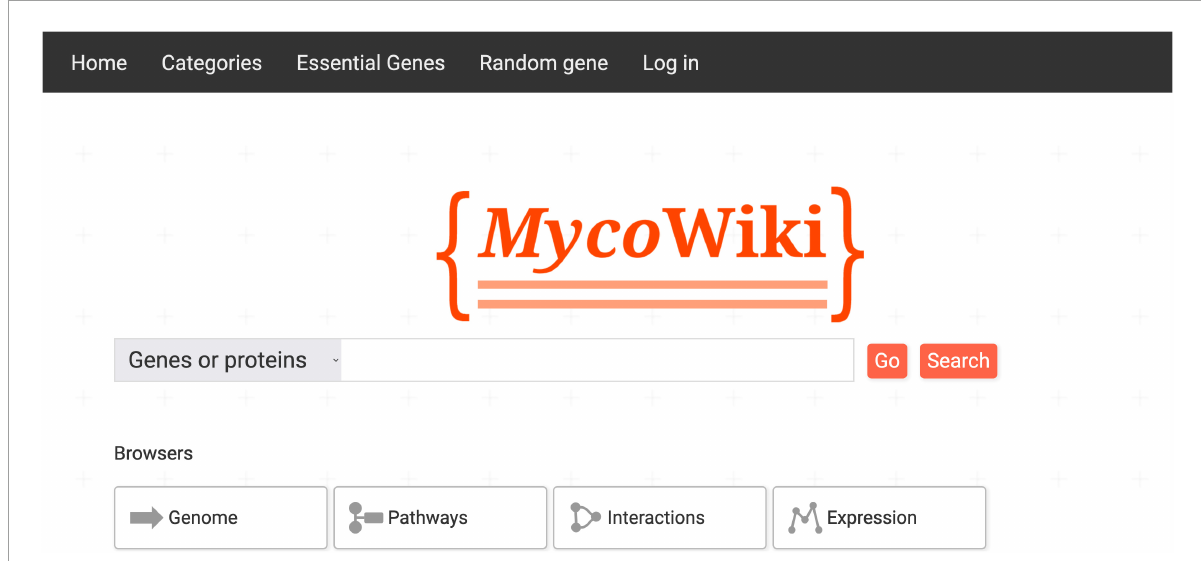
FIGURE1 Front page of Myco Wiki. The central search bar allows to query genes by name or locus tag, but also facilitates full-text searches. Below, the data browsers are linked for quick access. In the top bar, direct access to an overview of categories and a list of essential genes is provided, and utility links for jumping to a random gene page and for logging in.